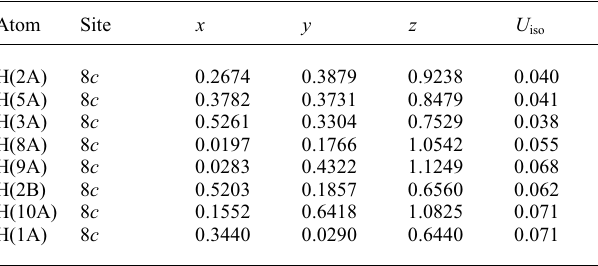
Table 2. Atomic coordinates and displacement parameters (in Å 2 ) .